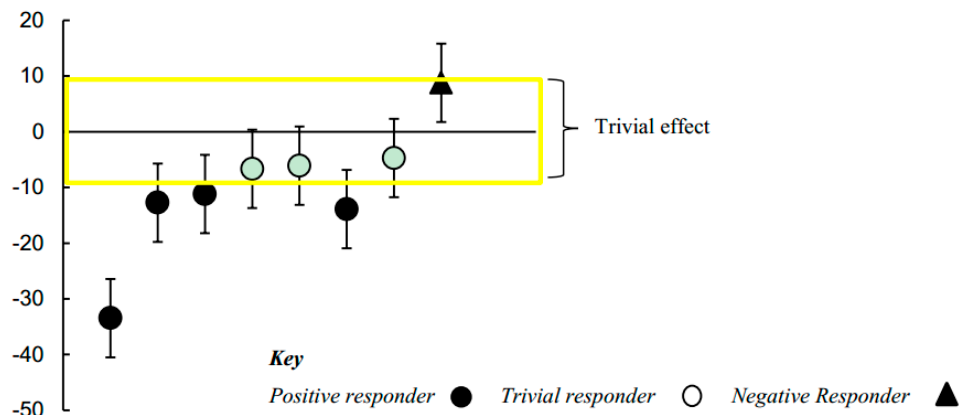
Figure 2. Pre-post study changes in Stereotyped Behaviors for individual children, with 95% confidence limits.